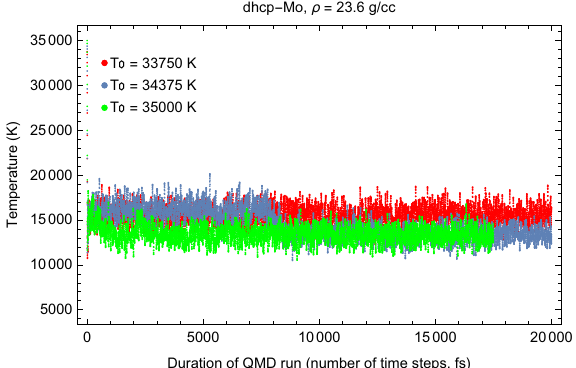
Figure 3. The same as in Figure 1 for double hexagonal close-packed (dhcp) Mo.